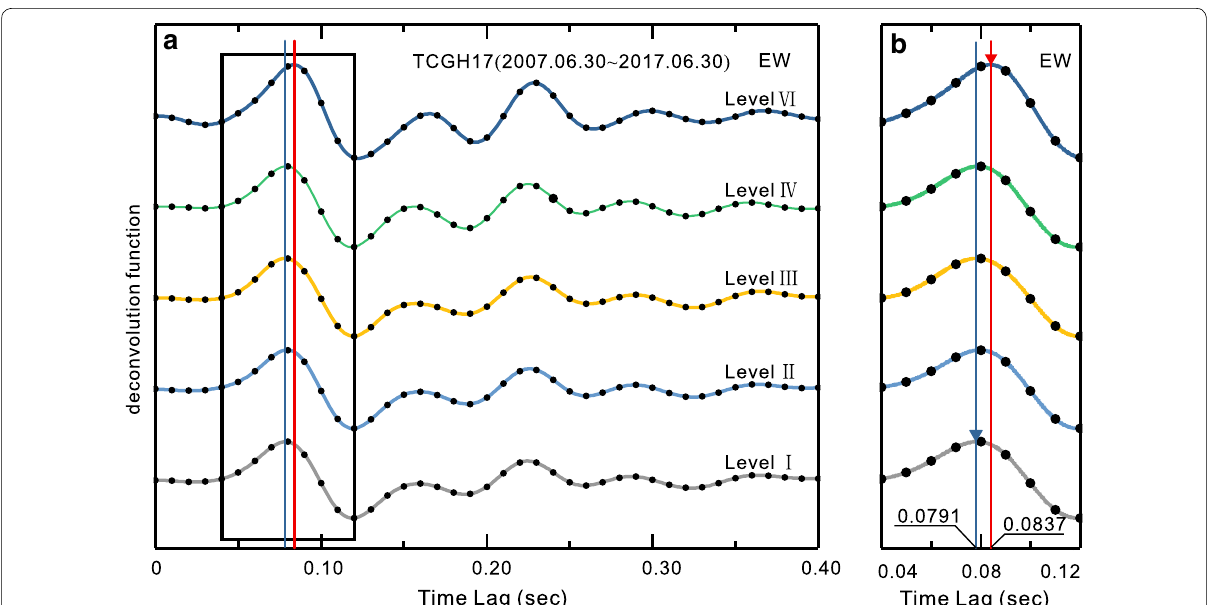
Fig. 3 a Deconvolution functions of different rainfall classes for the EW direction at TCGH17 station. Note that there is no seismic record with rainfall class V at TCGH17 as shown in Table 3. b Enlargement of a . The two vertical lines indicate the peak times of the deconvolution